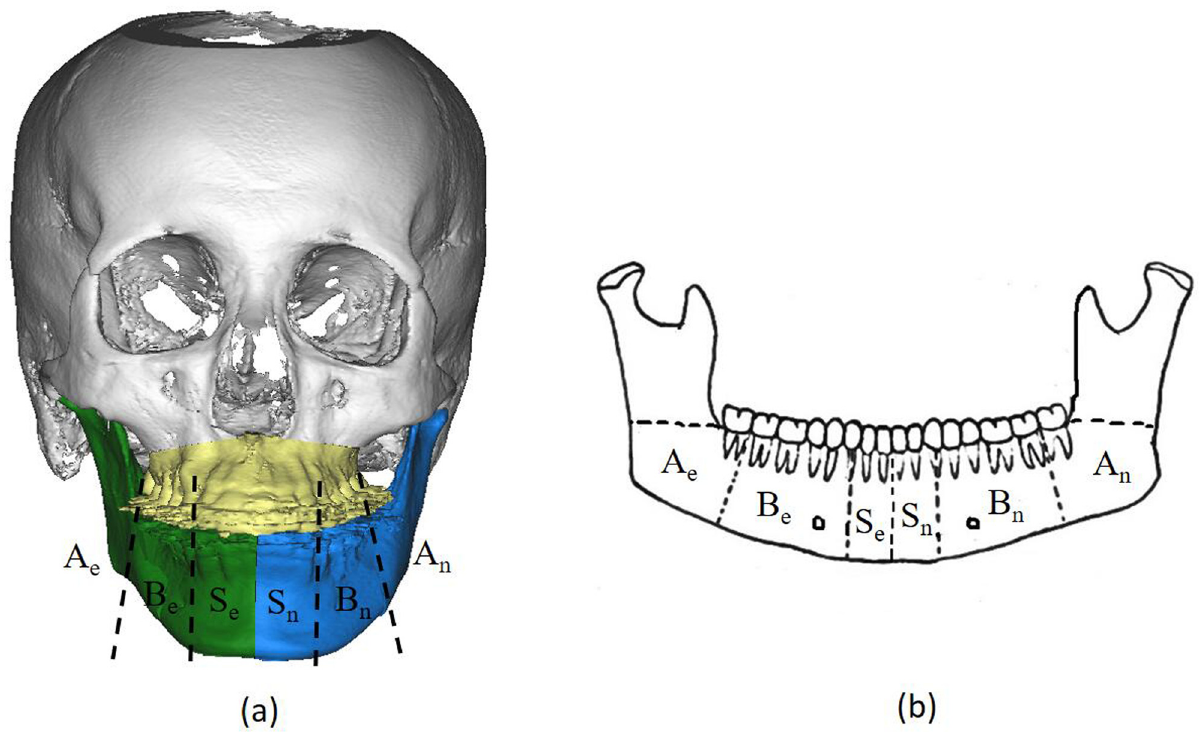
Fig 2. Mandibular division: (a) Both sides of hemi-mandible were divided into three regions respectively after virtual Me point correction; (b) Schematic diagram of three mandibular regions: S, Symphysis and parasymphysis mental region; M, Mandibular body region; A, Mandibular angle region; the subscripts e, n represent elongation and normal